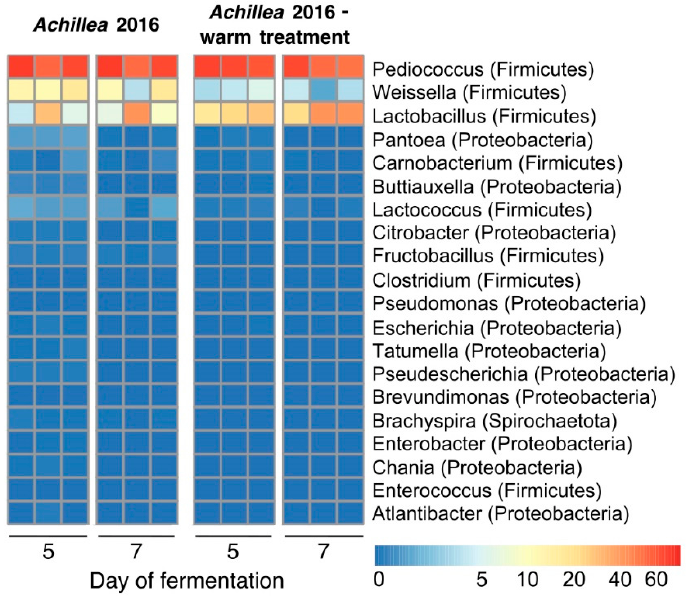
Figure 9. Heat map of the 16S cDNA (rRNA) analysis of the 20 most abundant bacterial genera at days 5 and 7 during the fermentation of the preparations of Achillea 2016, according to GHP method 33c and without cooling (warm). Shown are data of each triplicate. The color code indicates percentages of the abundance of the total bacterial community.